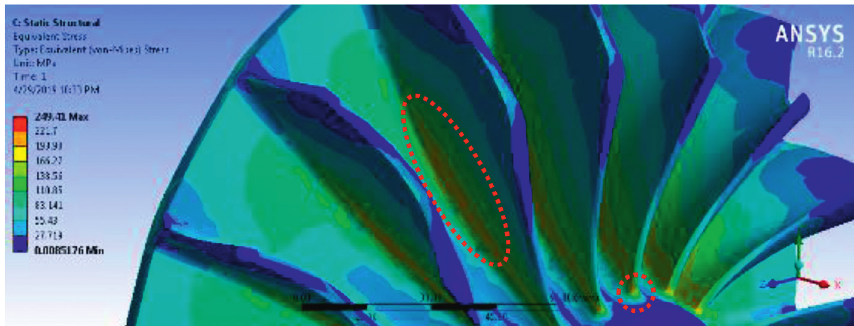
Figure 18: High magnification of the contour of von-mises for pressure difference of 0.1 in